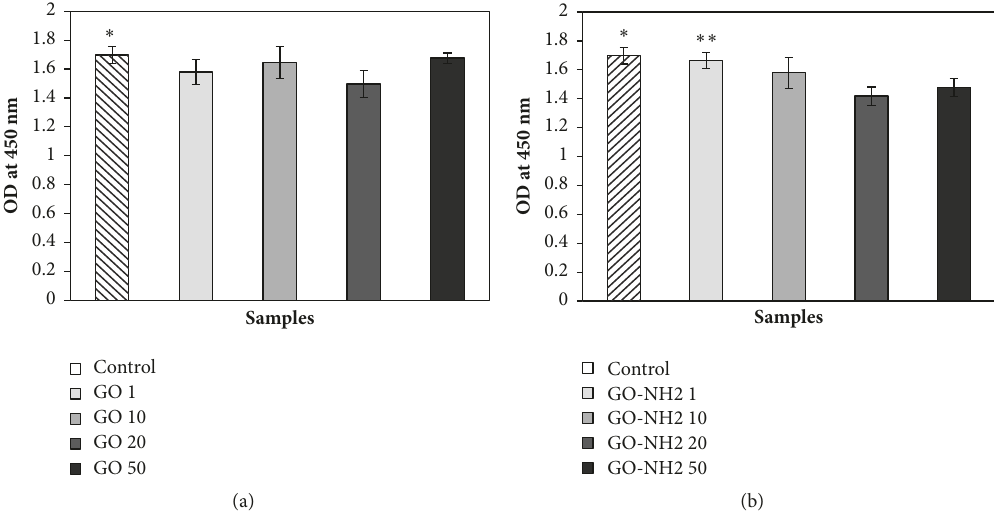
Figure 9: Viability of Lep3 cells after 24 hours incubation in the presence of ( 1 ) GO and (b) GO-NH 2